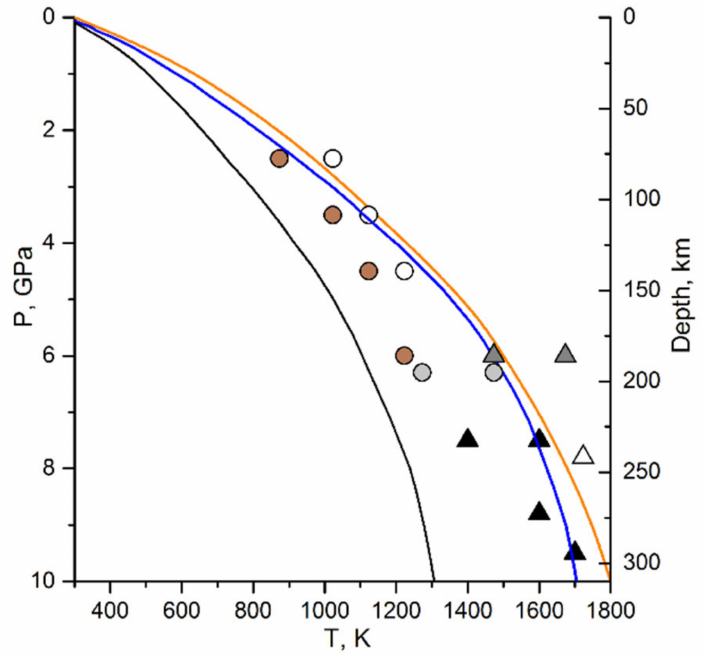
Figure 5. Experimental evidence of iron carbide formation (triangles) under the mantle pT con- ditions and hydrocarbon formation (circles) from iron carbide under the mantle pT conditions: Black triangles—experiments from [15], empty triangles—experiments from [2], grey triangles— experiments from [16], grey circles—experiments from [5], white circles—“poor” hydrocarbon systems, current research, brown circles—“rich” hydrocarbon systems, current research. Pressure- temperature profiles of the Earth’s geotherms (black curve—30 mW/m 2 continental geotherm, blue curve—40 mW/m 2 continental geotherm, orange curve—40 mW/m 2 ocean geotherm) are taken from Reference